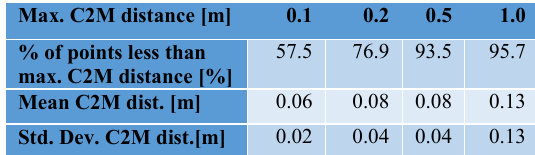
Table 1: Statistics describing the quality of the generated point cloud. The total number of points was 809861. The second row shows the percentage of points less than the maximum C2M distance specified in the first row. The third and fourth rows show the mean and standard deviation, respectively, of the C2M distances for the points referred to in the second row.